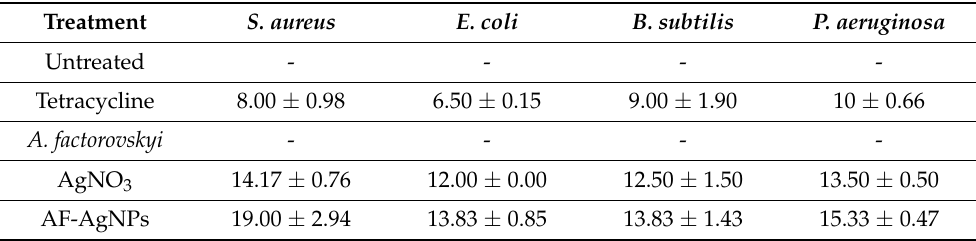
Table 4. The antibacterial activities of A. factorovskyi aqueous extract and AF-AgNPs by measuring the average of inhibition zone